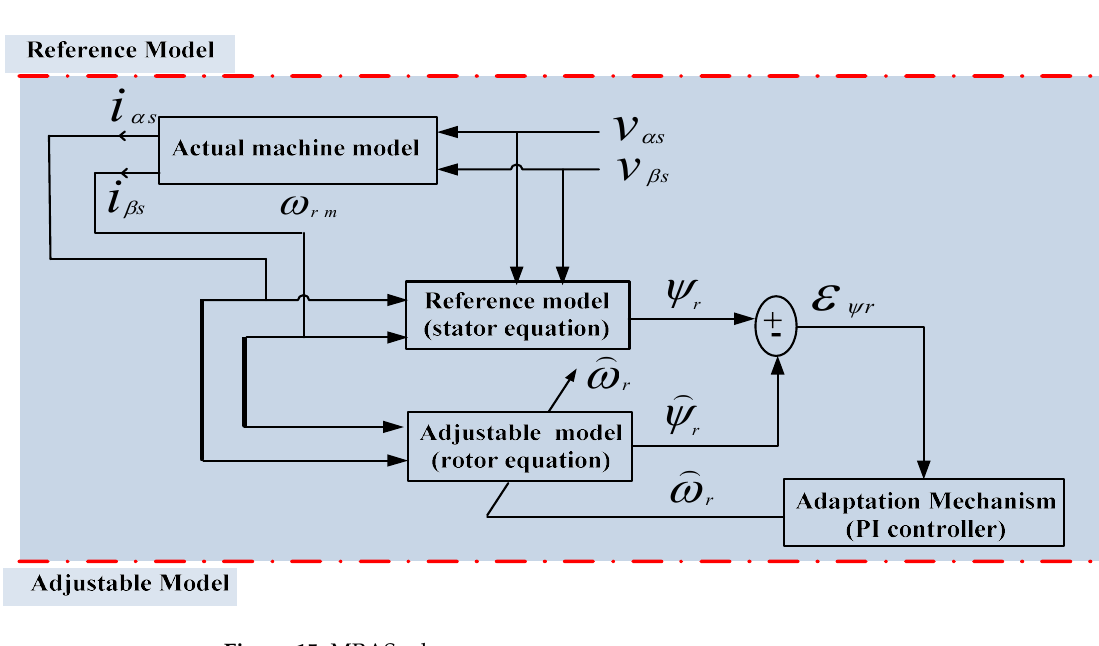
Figure 15. MRAS scheme.